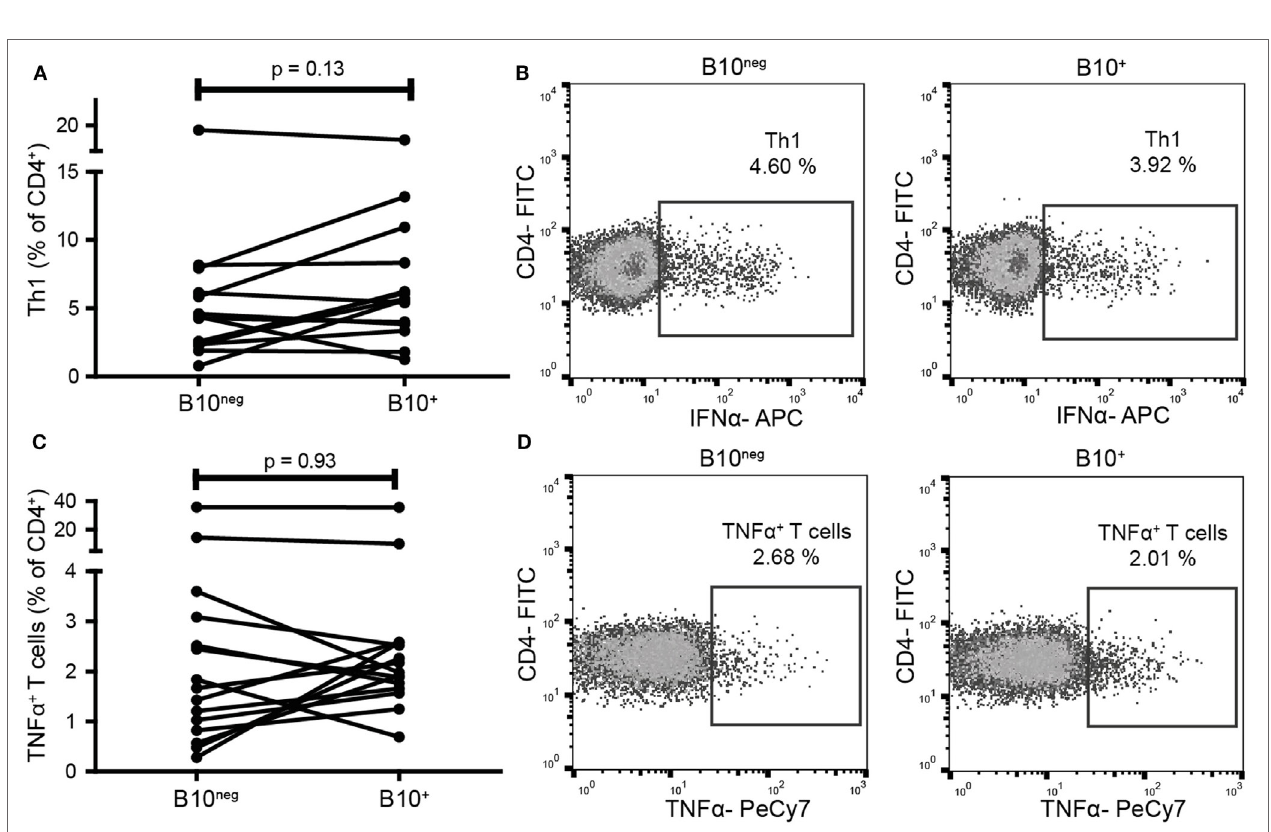
FigUre 3 | Regulatory functions of B10 + cells are mediated by IL-10 but also by cellular contacts. Sorted B10 + cells or B10 neg cells were co-cultured with autologous CD4 + CD25 − cells for 72 h and regulatory T (Treg) cells (defined as CD4 + CD25 hi CD127 lo/neg ) proportion was assessed by flow cytometry. (a) Anti IL-10 and recombinant IL-10 at 10 or 100 ng/mL were added to the co-culture, n = 3–7. (B,c) Same co-cultures as (a) but contact between B10 + cells and CD4 + CD25 − was prevented by membrane insert. (D) PBMCs were stimulated with CpG for 24 h and then CD80, CD86, PD-L1, and PD-L2 expression was assessed in B10 + and B10 neg subsets, n = 7–11. Percentages of B10 + and B10 neg cells positive for CD80, CD86, PD-L1, and PD-L2 are presented (left panel) and also median of fluorescence intensity (MFI) of CD80, CD86, PD-L1, and PD-L2 (right panel) in each subset. (e) Anti-CD80 ( α CD80), anti-CD86 ( α CD86), anti-PD-L1 ( α PD-L1), and anti-PD-L2 ( α PD-L2) were first incubated with B cells before co-culture. Variation in Treg cells, induced by each inhibitor, was expressed as a percentage, compared to the co-cultured B10 + /CD4 + CD25 − cells. Cumulative results for seven donors are shown for each condition, Wilcoxon matched pairs test. * p < 0.05, ** p < 0.01, *** p <